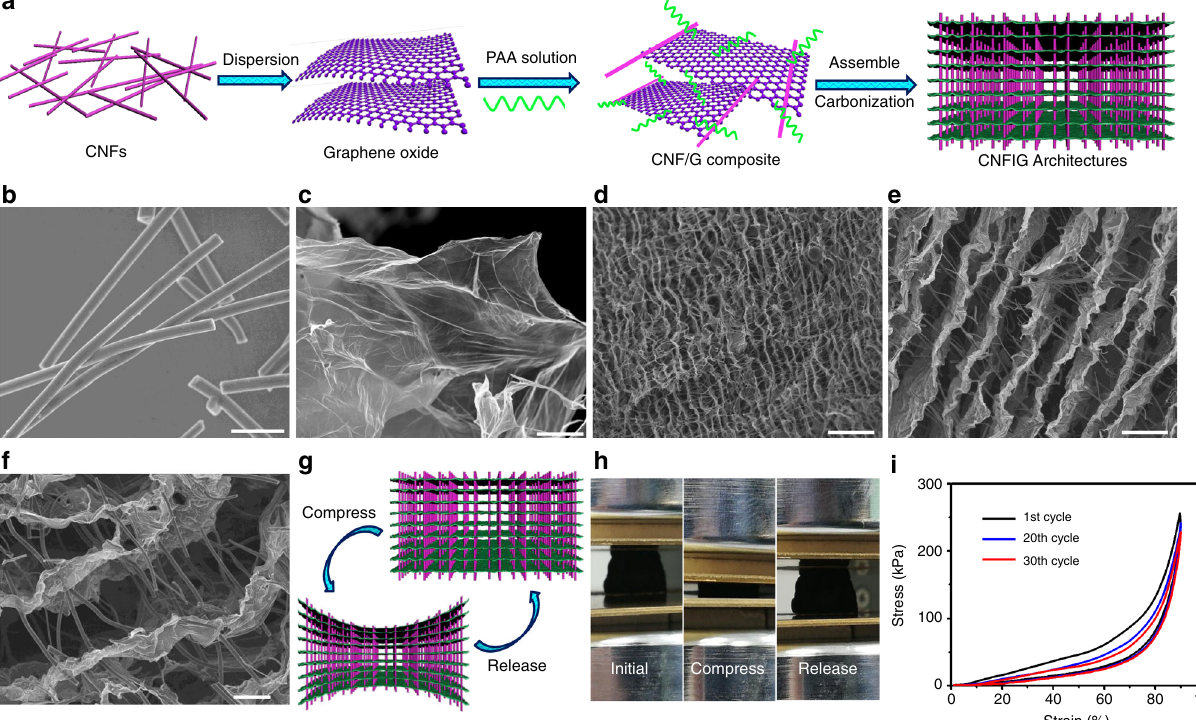
Fig. 1 Structure design and morphology of CNFIG. a Schematic illustration of the synthesis of ultra-stable CNFIG architecture based on CNFs and graphene sheets; SEM images of b CNFs (scale bar = 5 μ m) and c GO sheets (scale bar = 5 μ m); SEM images of CNFIG architectures at d low (scale bar = 30 μ m), e medium (scale bar = 20 μ m), and f high (scale bar = 10 μ m) magni fi cations; g schematic representation of the compressible ability of CNFIG; h digital photos of the CNFIG architecture being compressed; i Stress-strain curves of CNFIG at the 1st, 20th, and 30th